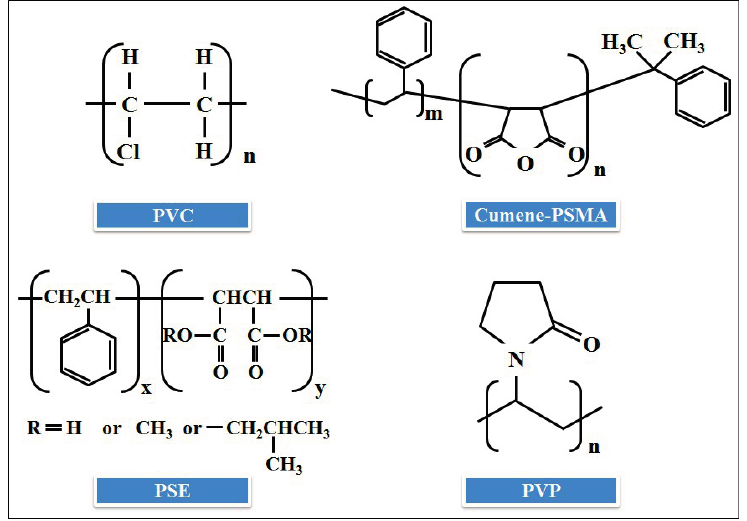
Figure 1. Structures of polyvinyl chloride (PVC), cumene terminated polystyrene-co-maleic anhydride (cumene-PSMA), poly(styrene-co-maleic acid) partial isobutyl/methyl mixed ester (PSE) and polyvinylpyrrolidone